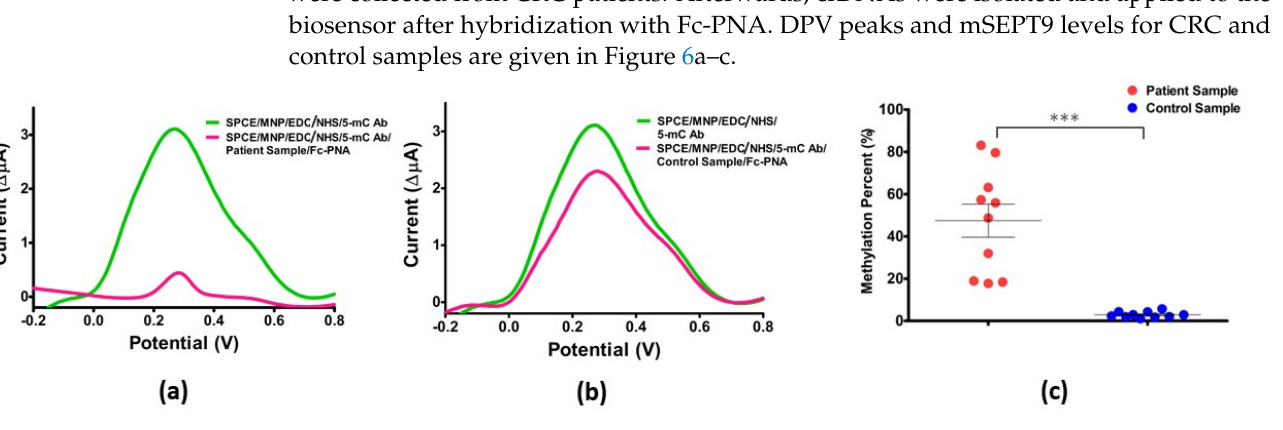
Figure 6. ( a ) Representative DPV peak forCRC plasma sample. ( b ) Representative DPV peak for control plasma sample. ( c ) mSEPT9 levels obtained from the developed sensor (***: p < 0.001) .